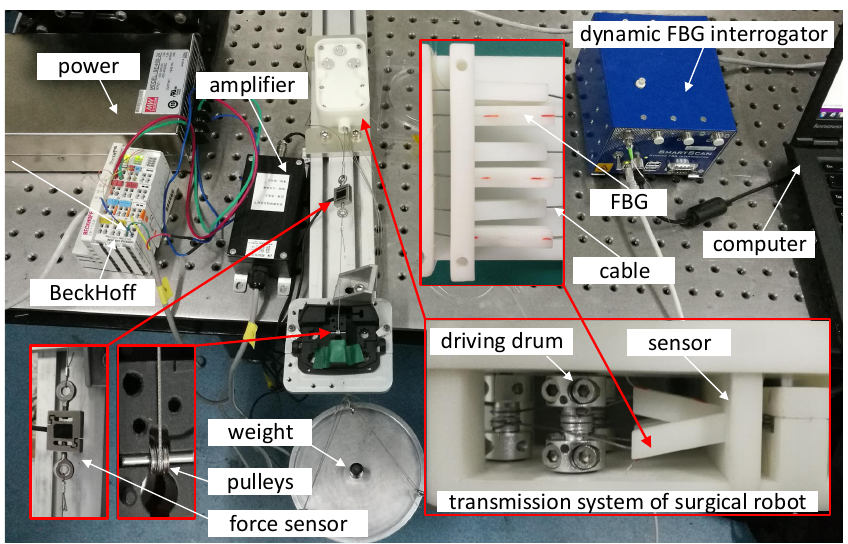
Figure 13. Experiments to investigate and test the proposed sensor mounted in the transmission system of surgical robot.